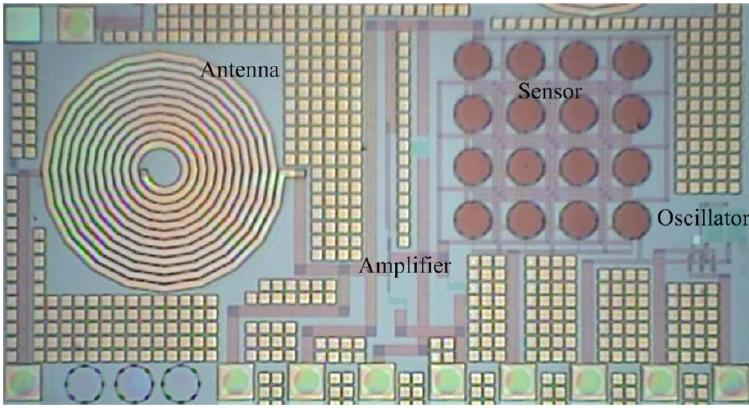
Figure 10. Photograph of the wireless pressure sensor after the wet etching process.